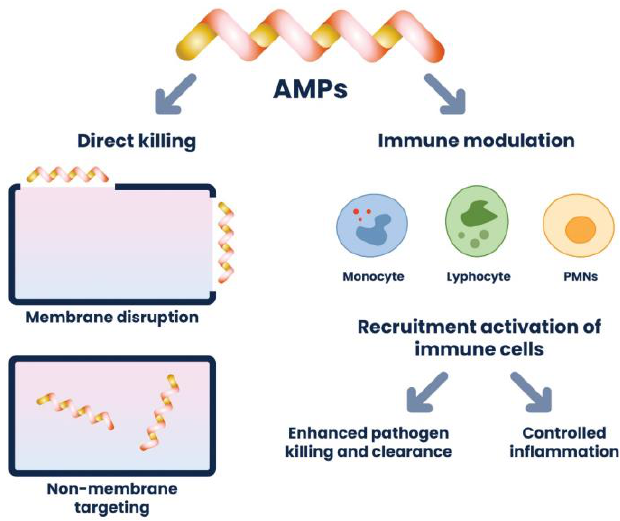
Figure 8. Mechanisms of action of antimicrobial peptides.